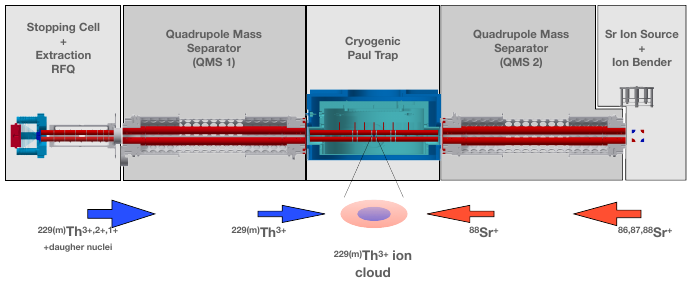
Figure 1. Visualization of the experimental setup and concept. A detailed explanation is provided in the text. 229(m) Th ions are produced in the α -decay of 233 U and extracted by a buffer-gas stopping cell and an extraction radio frequency quadrupole (RFQ). A quadrupole mass separator (QMS) allows for the selection of a specific charge state, which enables the loading of 229(m) Th 3 + into a cryogenic Paul trap. Sr ions produced by an ion dispenser source are bent by 90° by an electrostatic ion bender and are then injected into a QMS that selects 88 Sr + from other naturally occurring Sr isotopes. 88 Sr + ions are loaded into the cryogenic Paul trap and can be laser